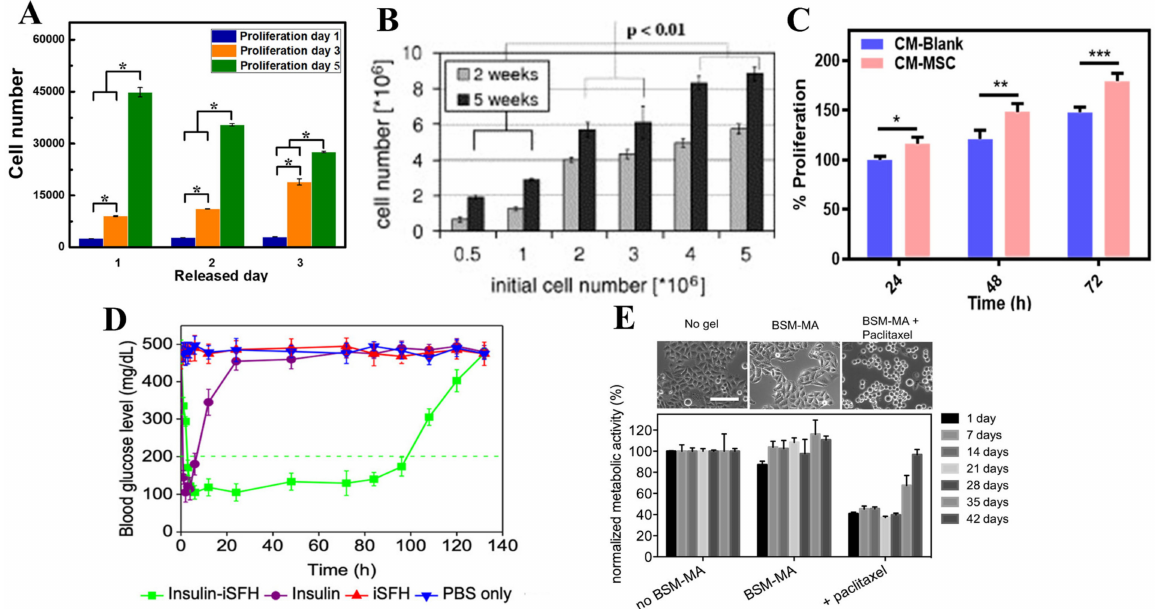
Figure 5. ( A ) The proliferation of the C2C12 cells on dextran-graft-aniline tetramer-graft-4- formylbenzoic acid and N-carboxyethyl chitosan hydrogels after being released for 1–3 days (* p < 0.05) [82]. ( B ) The effects of the initial chondrocyte cell number on the cell proliferation of fibrin with calcium ion hydrogels in weeks 2 and 5 [85]. ( C ) The proliferation of fibroblast from carboxymethyl chitosan and carboxymethyl cellulose dialdehyde hydrogel with and without mes- enchymal stem cells (*** p ≤ 0.001, ** p ≤ 0.01, and * p ≤ 0.05) [86]. ( D ) Blood glucose levels with several methods demonstrate that insulin-loaded injectable silk-fibroin protein hydrogel maintains blood glucose levels the longest [87]. ( E ) Changes in morphological and metabolic activity of HeLA epithelial cancer cells during release of anti-cancer drug paclitaxel from mucin glycoprotein-based hydrogel (scale bar is 40 µ m) [88]. Reproduced with permissions: ( A ) is from Elsevier, 2019; ( B ) is from Elsevier, 2007; ( C ) is from American Chemical Society, 2019; ( D ) is from American Chemical Society, 2020; ( E ) is from Elsevier,